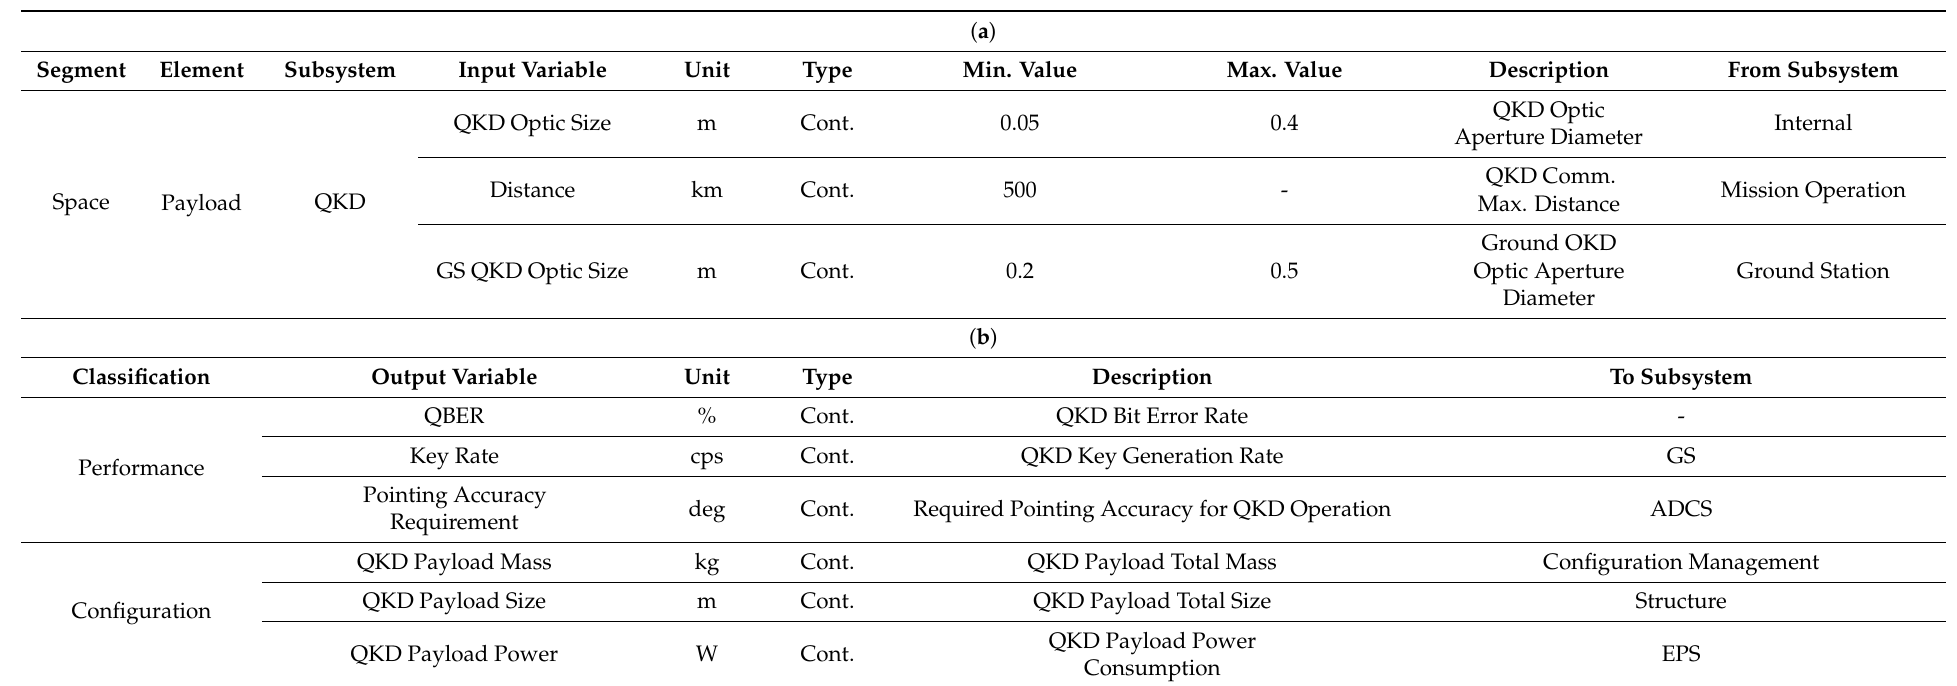
Table 4. Interface control document for QKD